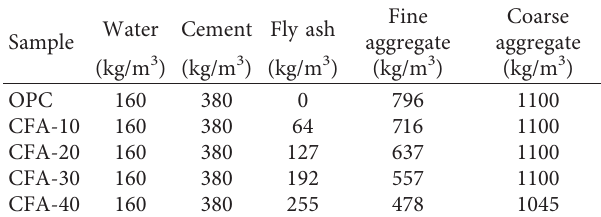
Table 3: Concrete mix ratio at different replacement rates. Water Cement Fly Sample